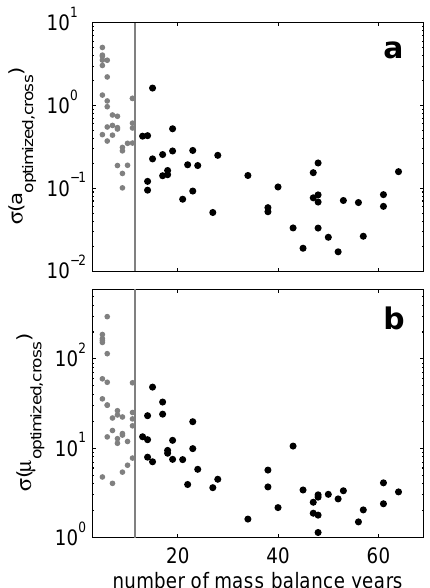
Fig. 3. Standard deviation of a k, cross (a) and µ k, cross (b) as a func- tion of the number of mass balance measurements. Black dots are the values of glaciers accepted into the final set, gray dots are those of the glaciers rejected from the final set. The gray vertical line indi- cates the minimum number of mass balance measurements (12yr) necessary to obtain robust results for a optimized and µ optimized .